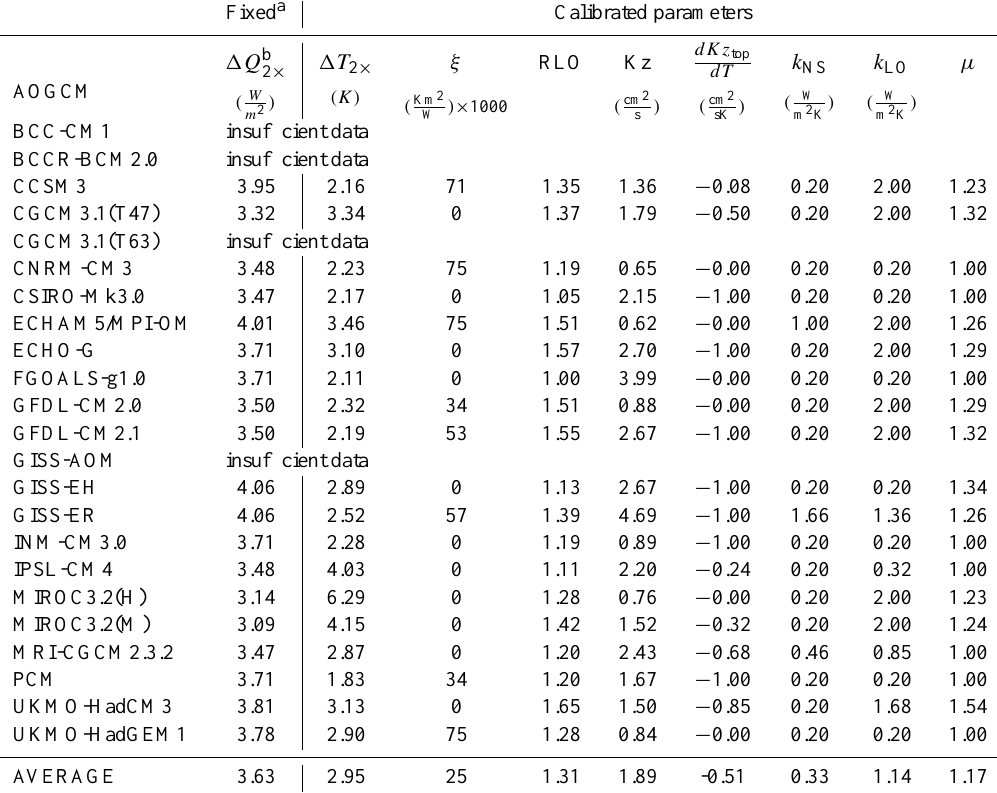
Table B2. AOGCM calibration II results: MAGICC6 parameters required to emulate CMIP3 AOGCM models using idealized scenarios and eight calibrated parameters. See Table